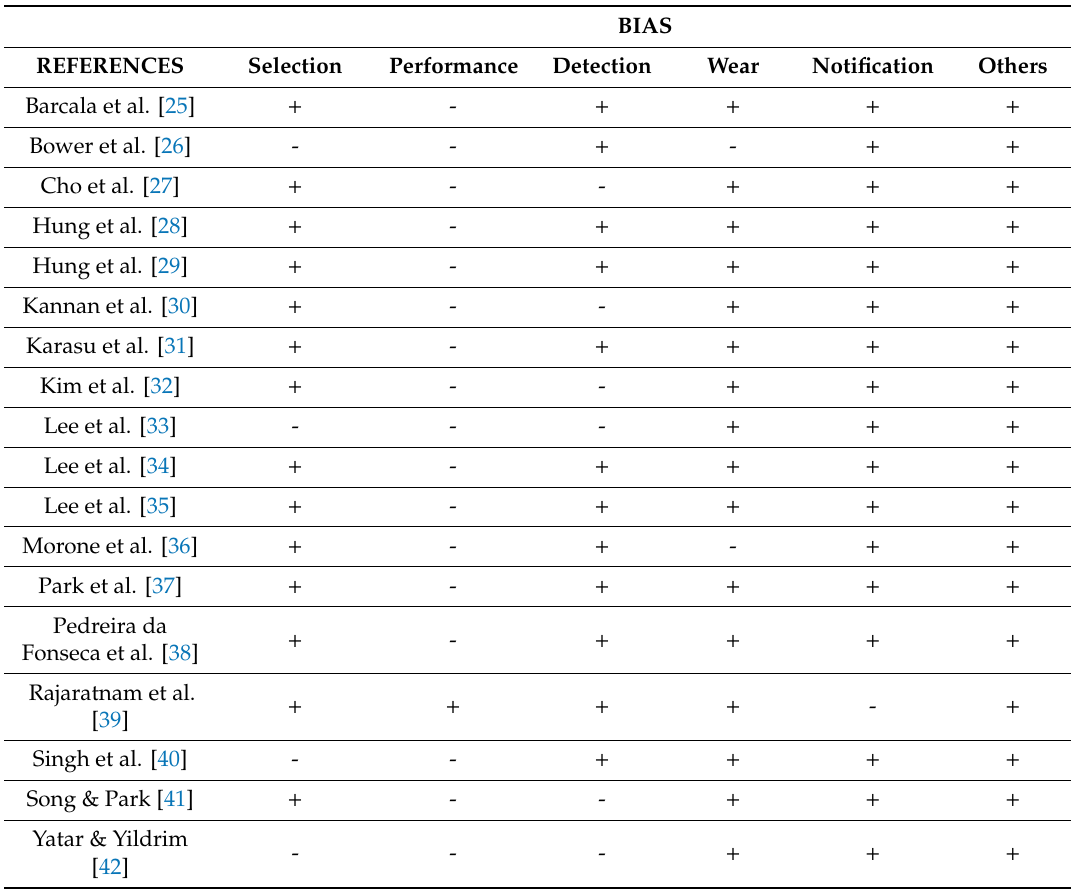
Table 5. Bias risk assessment of the articles included.